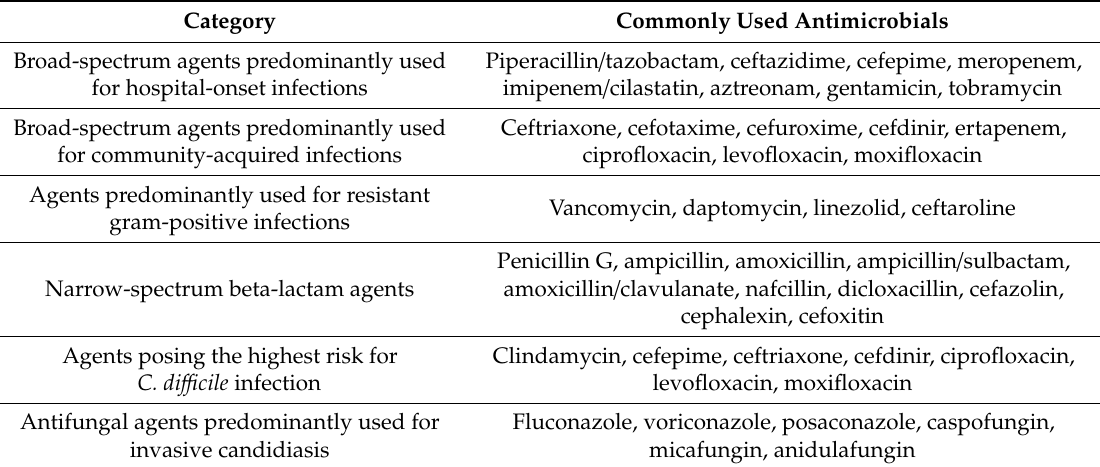
Table 3. Centers for Disease Control and Prevention National Healthcare and Safety Network antimicrobial use module